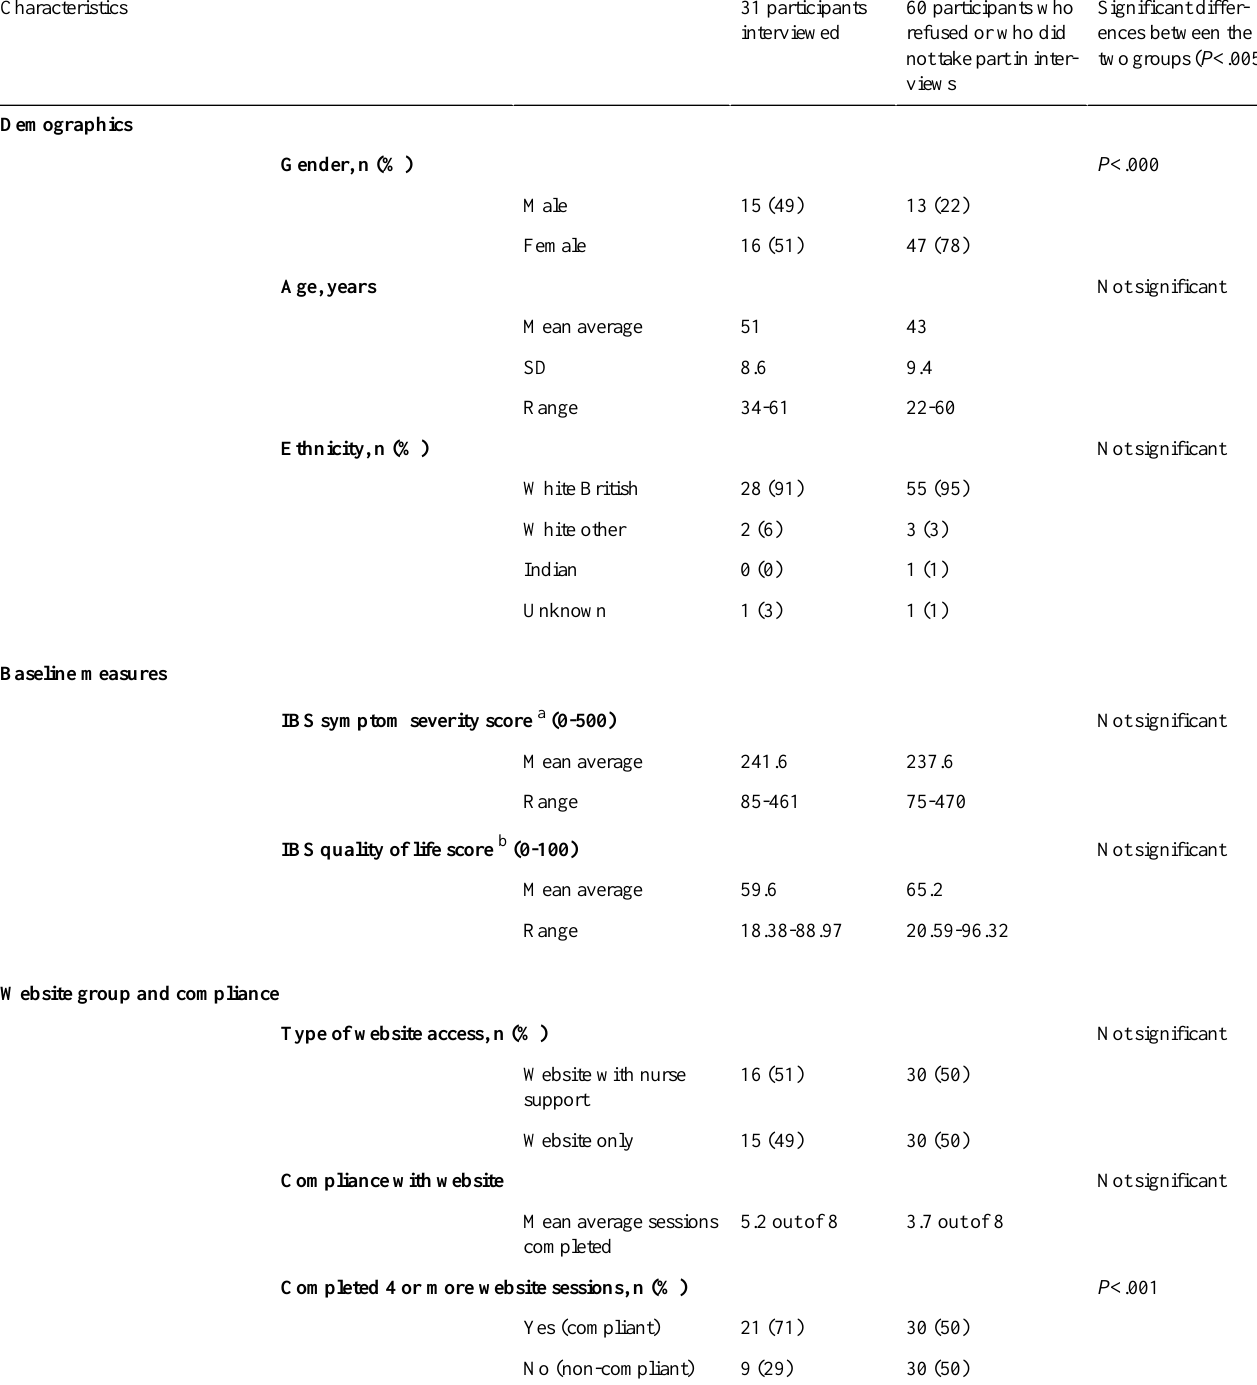
Table 1. Characteristics of 31 participants who took part in interviews compared to the 60 participants who received access to the Regul8 website in the main trial.